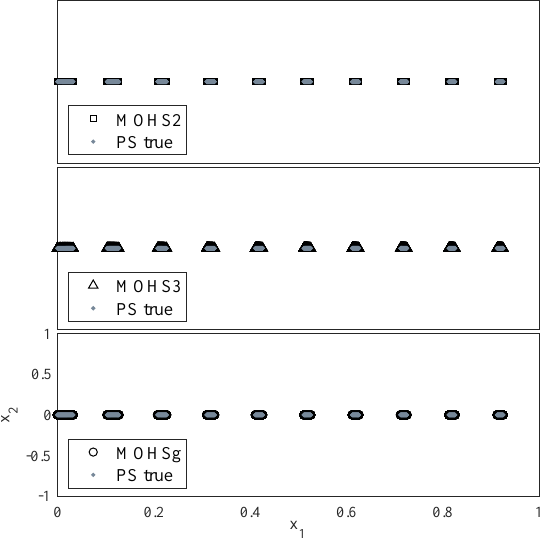
Figure 9. Pareto sets for problem P4.